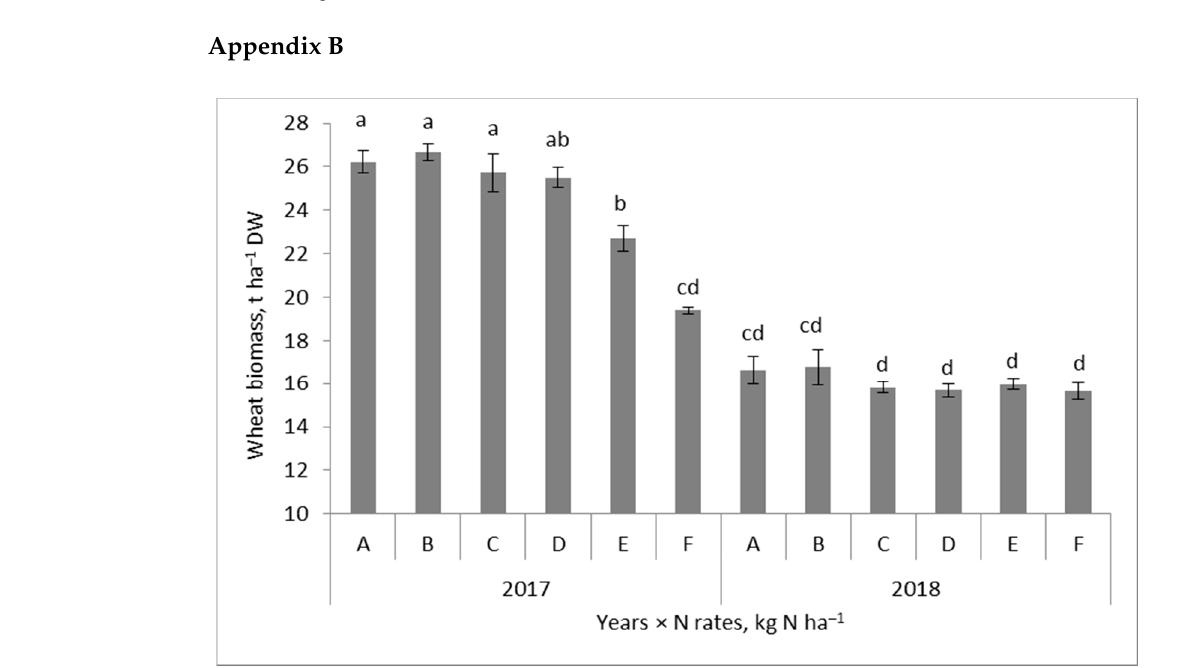
Figure A1. Effect of plant protection methods on the biomass of winter wheat at harvest. Similar letters indicate a lack of significant differences between experimental treatments using Tukey’s test. The vertical bar in the column is the standard error of the mean.